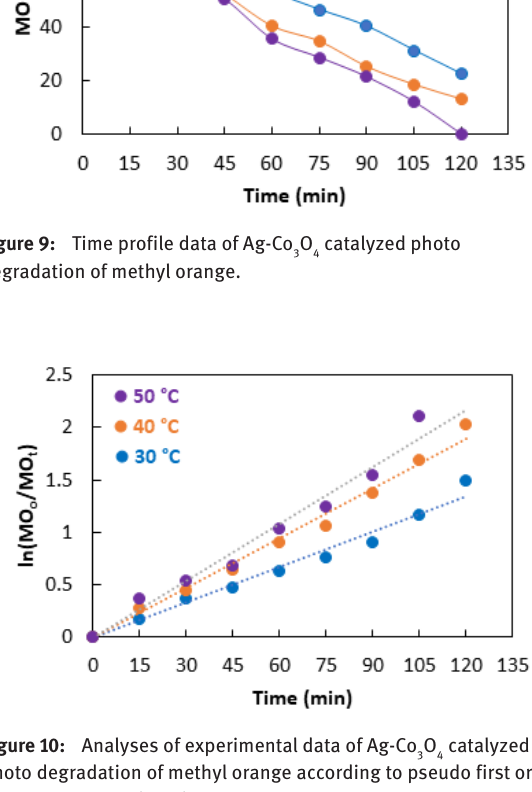
Figure 10: Analyses of experimental data of Ag-Co photo degradation of methyl orange according to pseudo first order kinetics equation (Eq. 3).